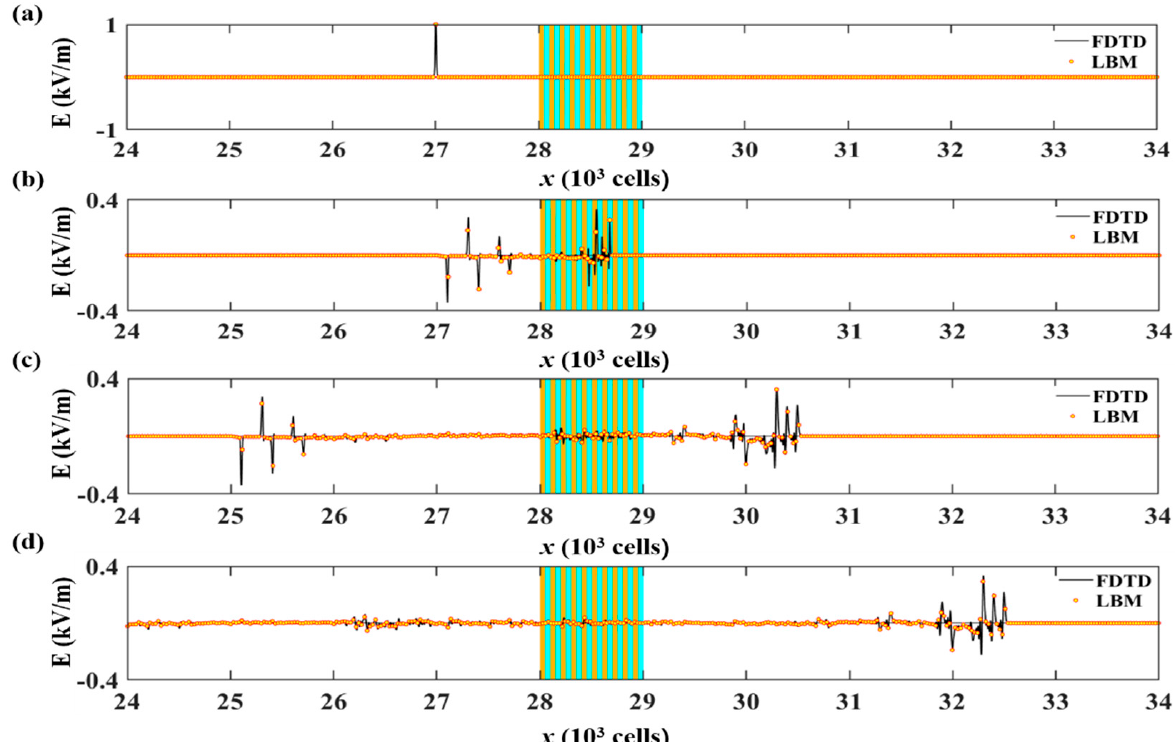
Figure 3. Snapshots of the electric field of an incident Gaussian pulse propagating in air and incident upon 1D plasma PhCs at different times: ( a ) 0, ( b ) 15.3, ( c ) 30.6, and ( d ) 45.9 fs. The properties of the plasma layer are ω p = 2.0 THz, ϑ c = 50 GHz. (Black solid curves are based on FDTD, and the curves with circular markers are based on the proposed method).